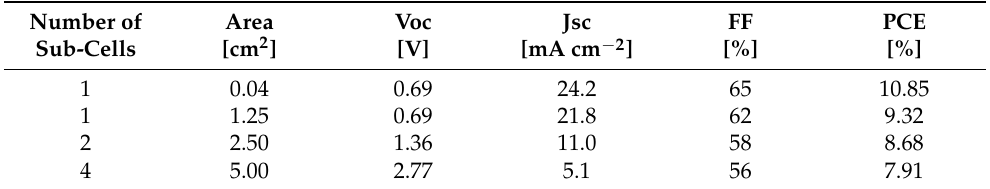
Table 1. Involved module parameters and photovoltaic performance (Average performance is statistically derived from testing the same batch of devices. The margin of error is within 5%).